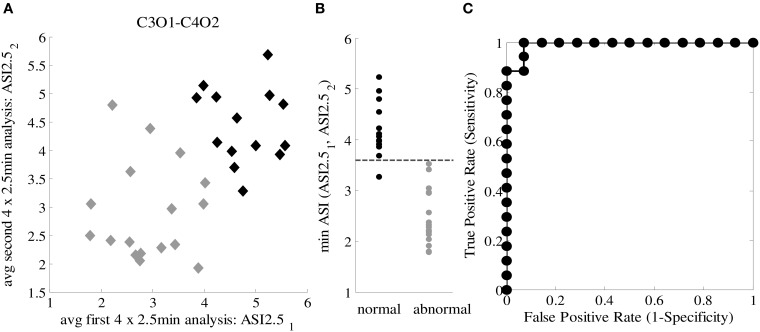
(A) ASI2.51 and ASI2.52 for both 10-min EEG segments from 31 patients for C-O derivation with the lowest MSD value. Two groups are specified: normal patients (black labels) and abnormal patients (gray labels). (B) Discrimination between normal and abnormal ASI taking the minimum ASI of ASI2.51 and ASI2.52 and thresholding (Th_ASI = 3.6). (C) ROC curve for classification, AUC = 0.971.